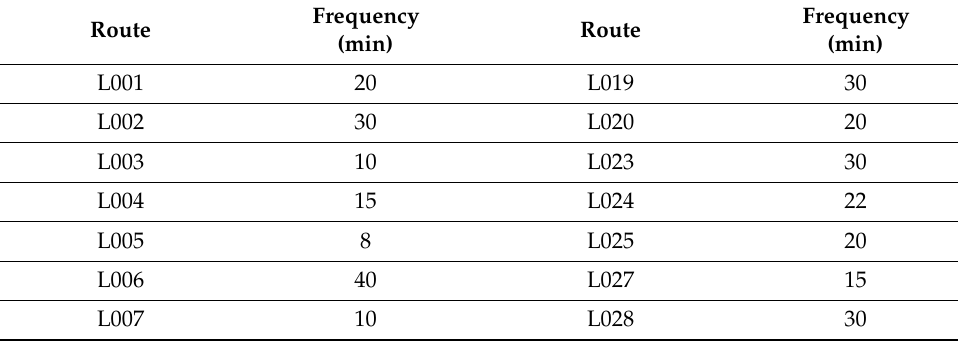
Table 2. Bus lines and frequencies. Source: Empresa Municipal de Transports de Palma, 2020